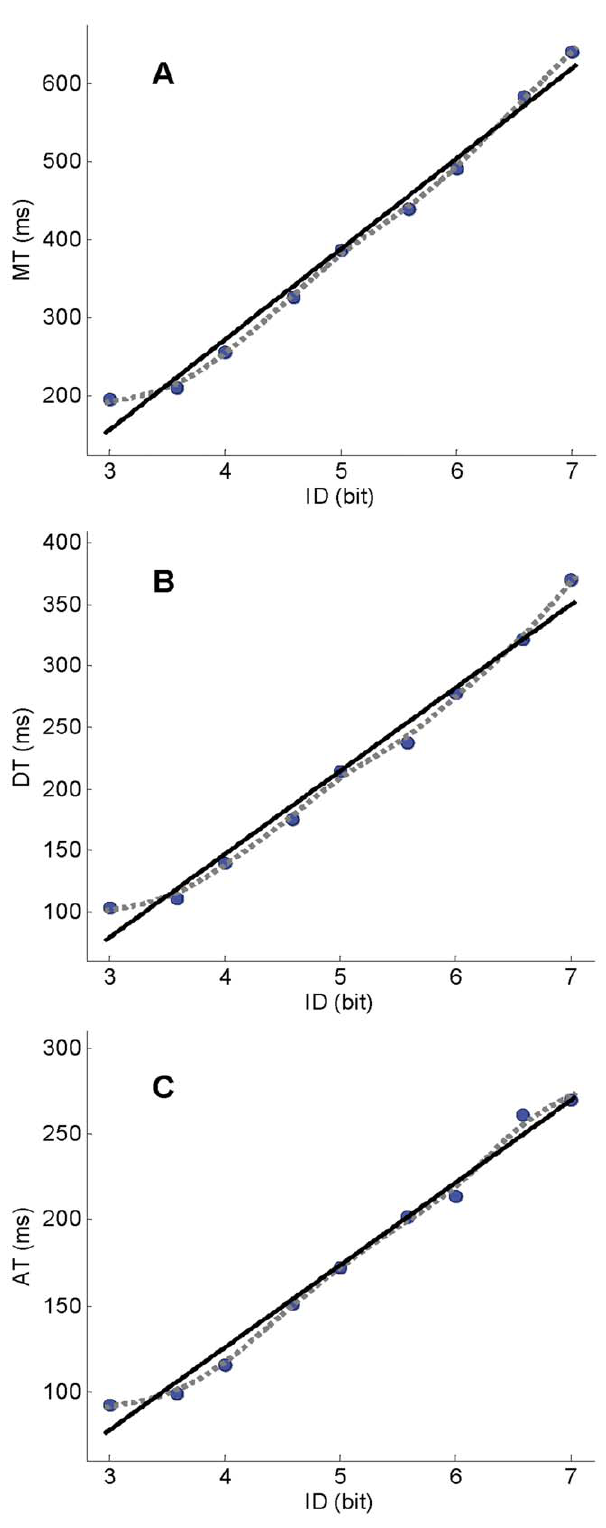
Figure 3 . Data and fittings for experiment 2. (A) Movement time; (B) deceleration time; and (C) acceleration time. Each dot represents mean value across participants for the corresponding ID condition. Dashed grey lines represent spline fitting curves. Black lines represent linear regressions.